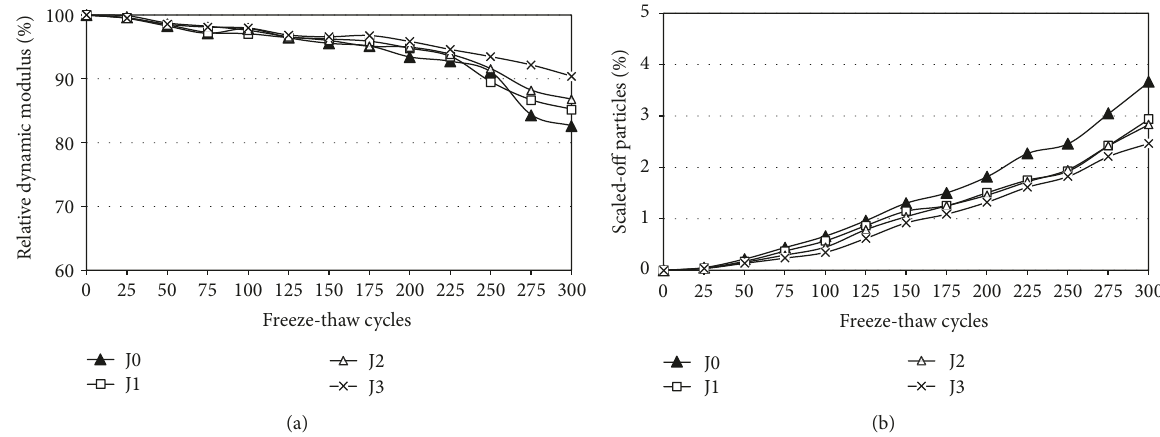
Figure 7: Polymer modified concrete with 0.013% of the air-entraining agent under freeze-thaw cycles: (a) relative dynamic modulus and (b) percentage of scaled-off